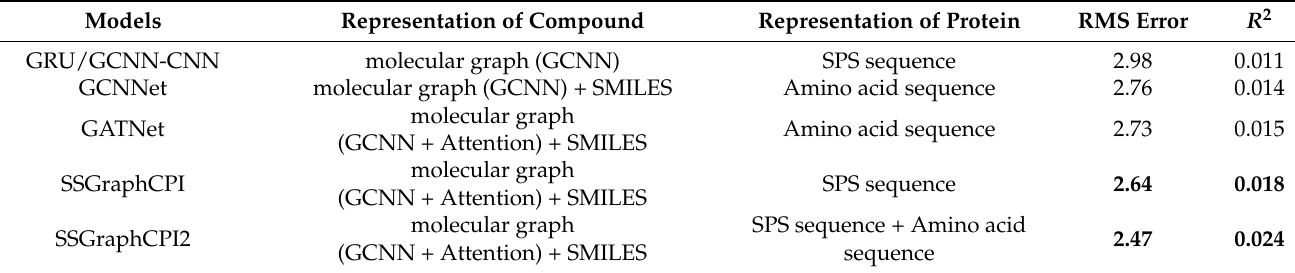
Table 5. RMS errors of different models on the Kinase dataset.